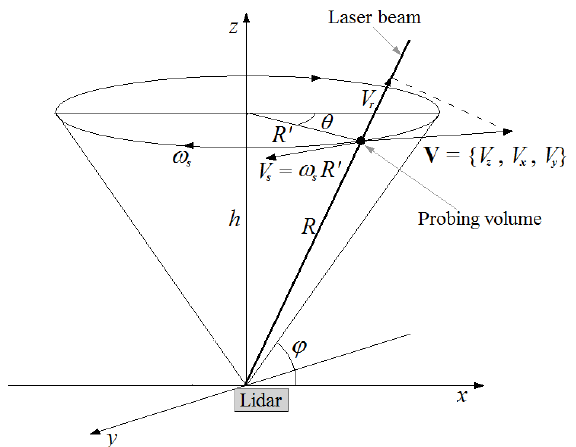
Figure 1. Geometry of measurement by a pulsed coherent Doppler lidar with conical scanning by laser beam.